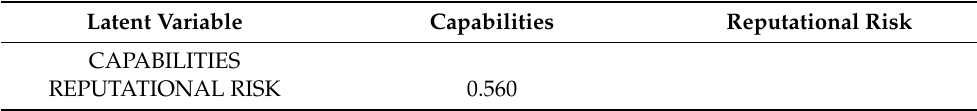
Table 3. Heterotrait-Monotrait Ratio (HTMT).